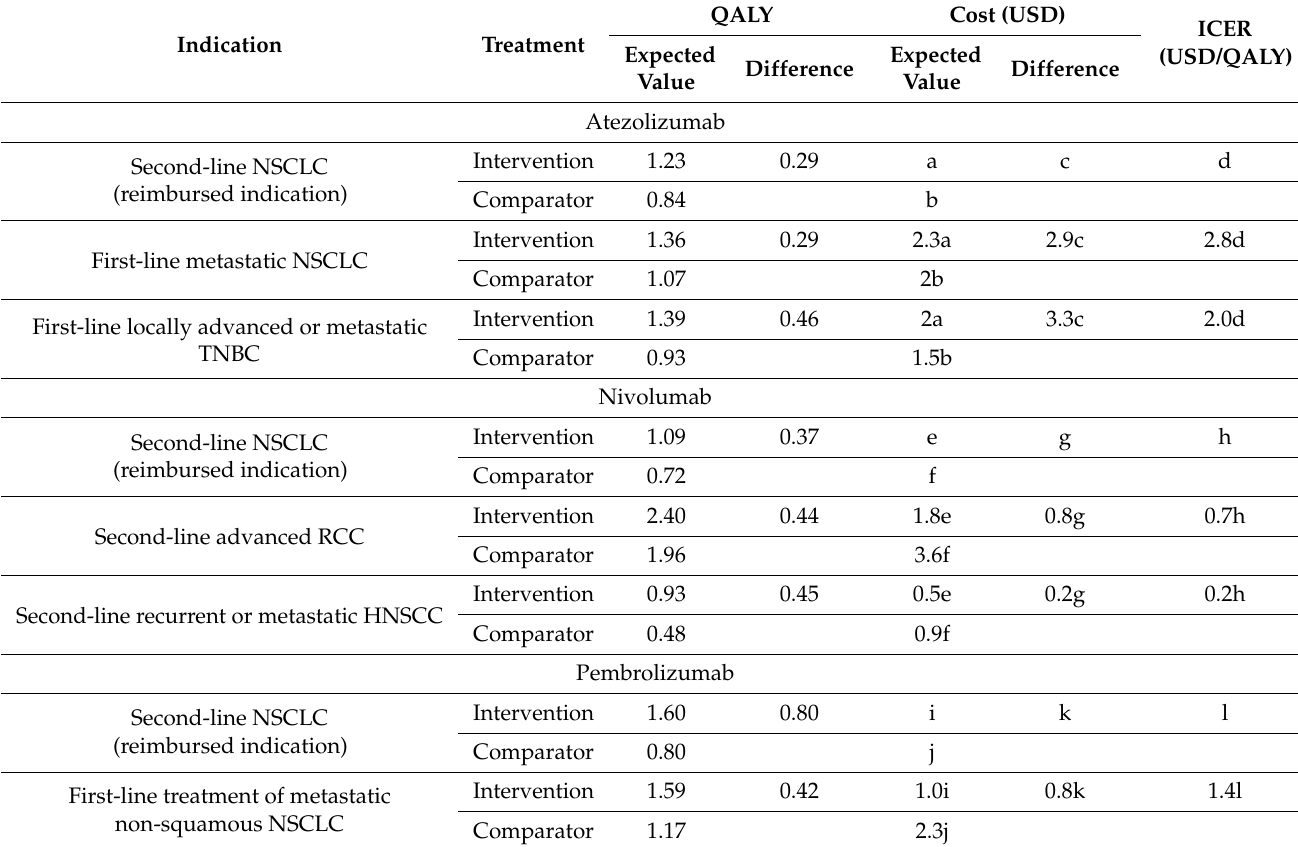
Table 1. The results for cost-effectiveness analysis for each indication of